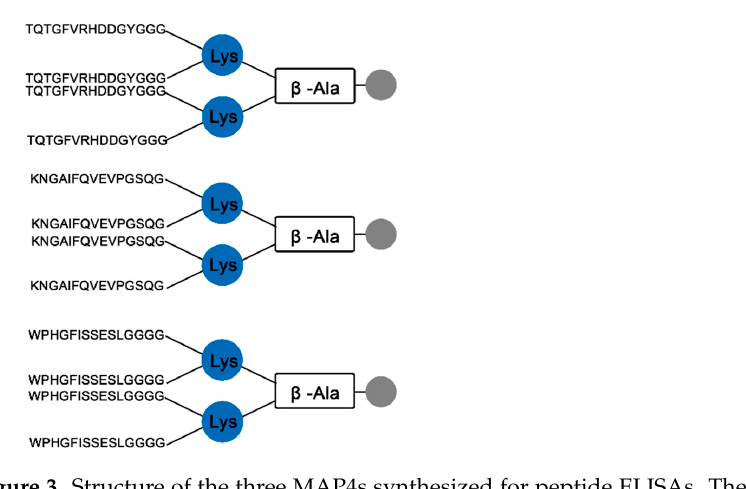
Figure 3. Structure of the three MAP4s synthesized for peptide ELISAs. The Wang resin used for F-moc peptide synthesis generated a dendrimer with four copies of the epitope ( A ) TxA-3, ( B ) TxB-11, and ( C ) TxP-15.